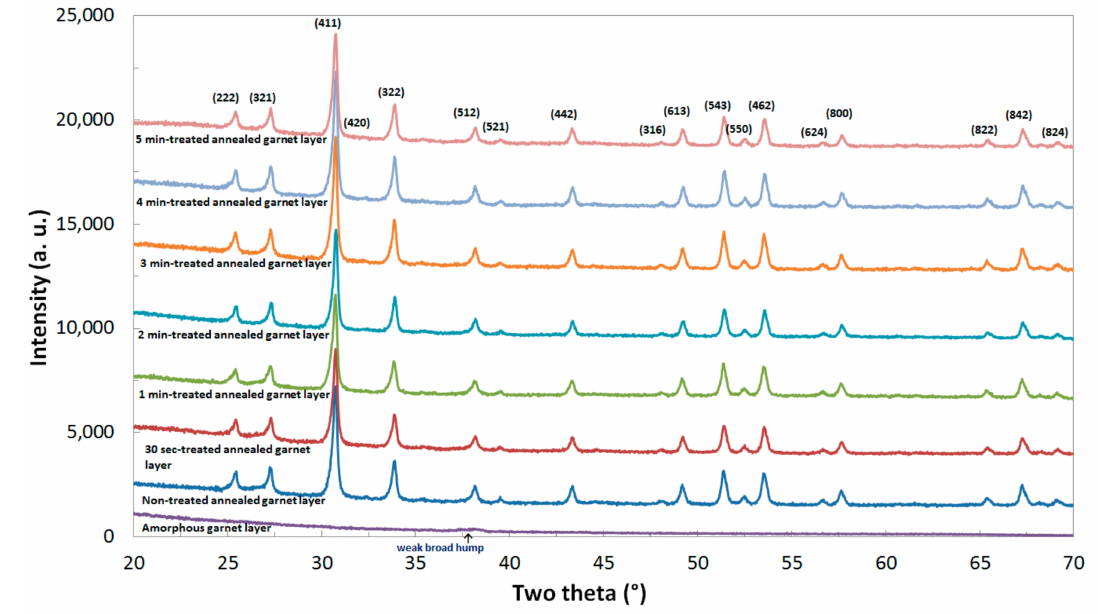
Figure 3. Measured X-ray di ff raction (XRD) patterns in as-deposited and